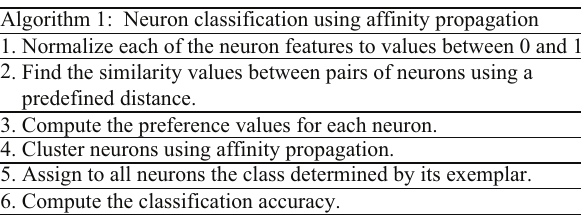
Algorithm 1: Neuron classification using affinity